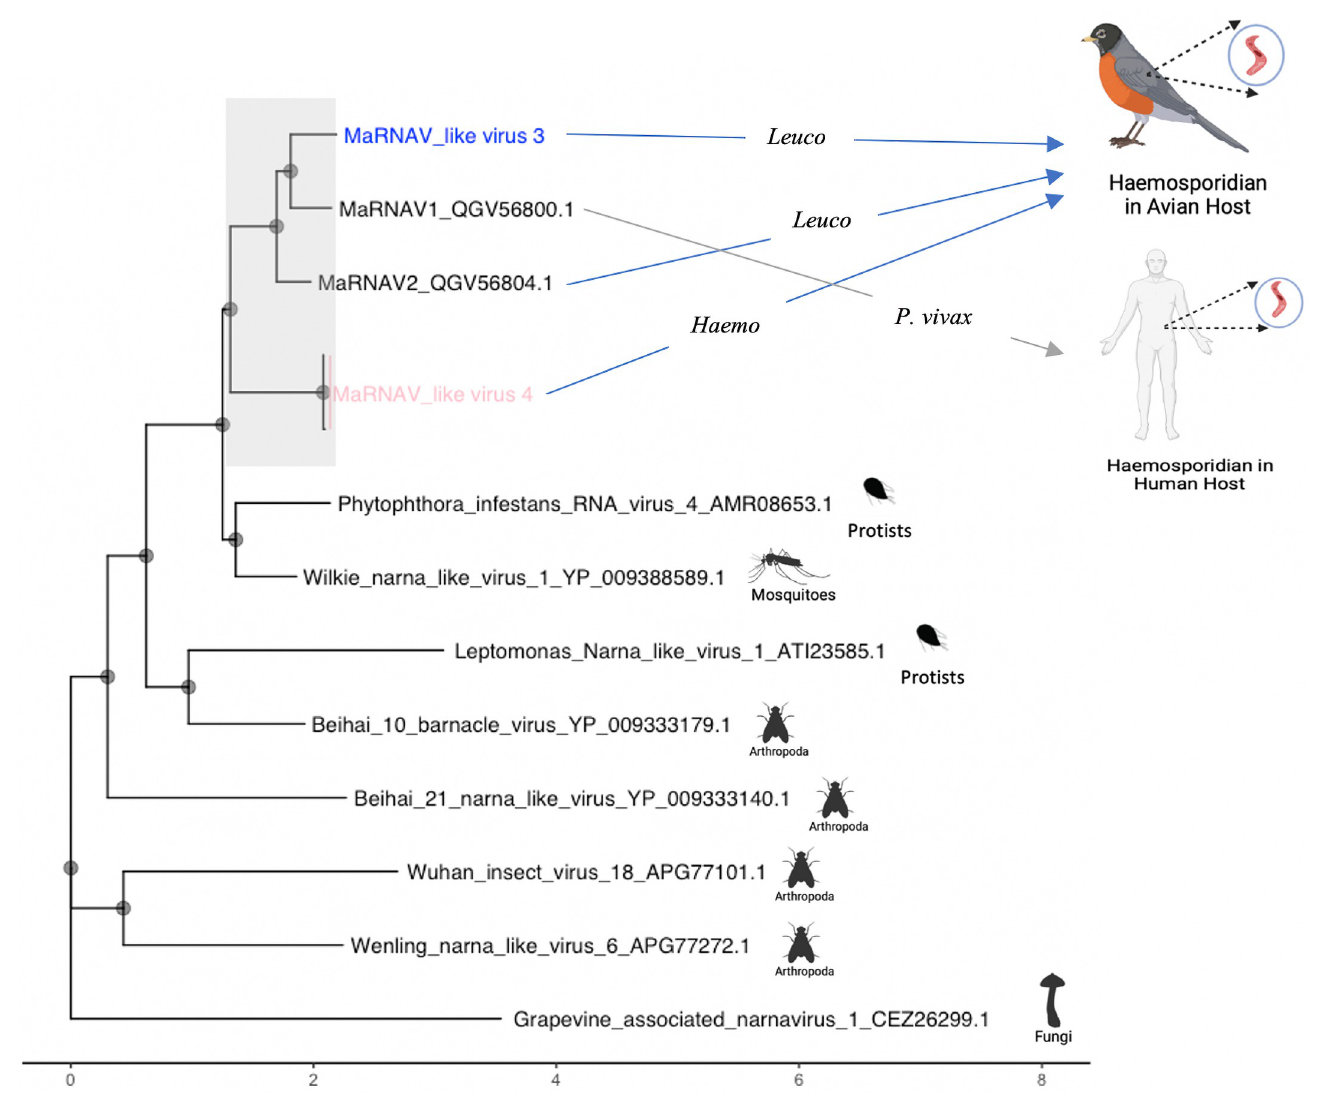
Fig 1. Phylogeny of possible RNA viruses associated with avian haemosporidian parasites. Phylogenetic tree comparing the most closely related RdRps of MaRNAV3 and MaRNAV4 from the NCBI non-redundant protein database. The images on the right side are the expected host or environments where RNA viruses were discovered (Icons from BioRender.com). Sequences were aligned using the E-INS-I algorithm in MAFFT v7.309. Aligned sequences were put into IQ- tree v1.6.10, which chose the LG+F+I+G4 model according to BIC. The scale refers to the number of nucleotide substitutions per codon site, and the tree is unrooted although the taxon Grapevine associated narnavirus is drawn at the root. Created with BioRender.com.